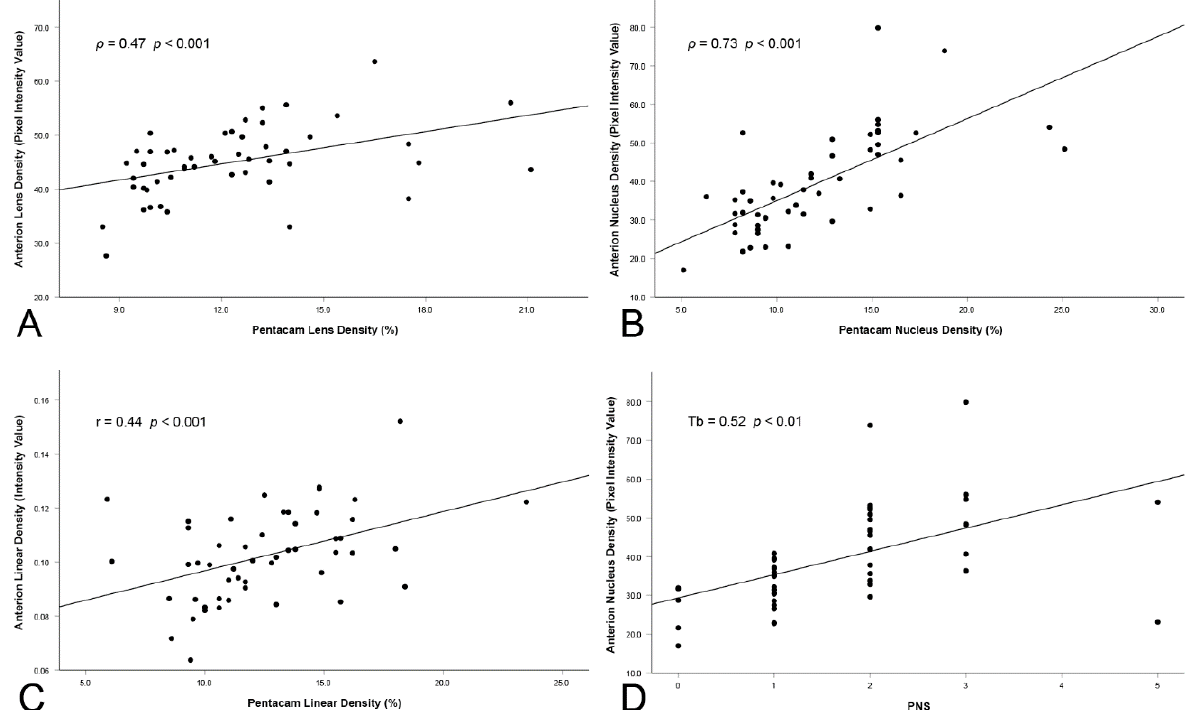
Figure 4. Scatter plots of the correlations between SS-OCT and Scheimpflug imaging using the ( A ) lens method, ( B ) nucleus method and ( C ) linear method. ( D ) is the correlation between PNS and the nucleus method used on the SS-OCT scans.